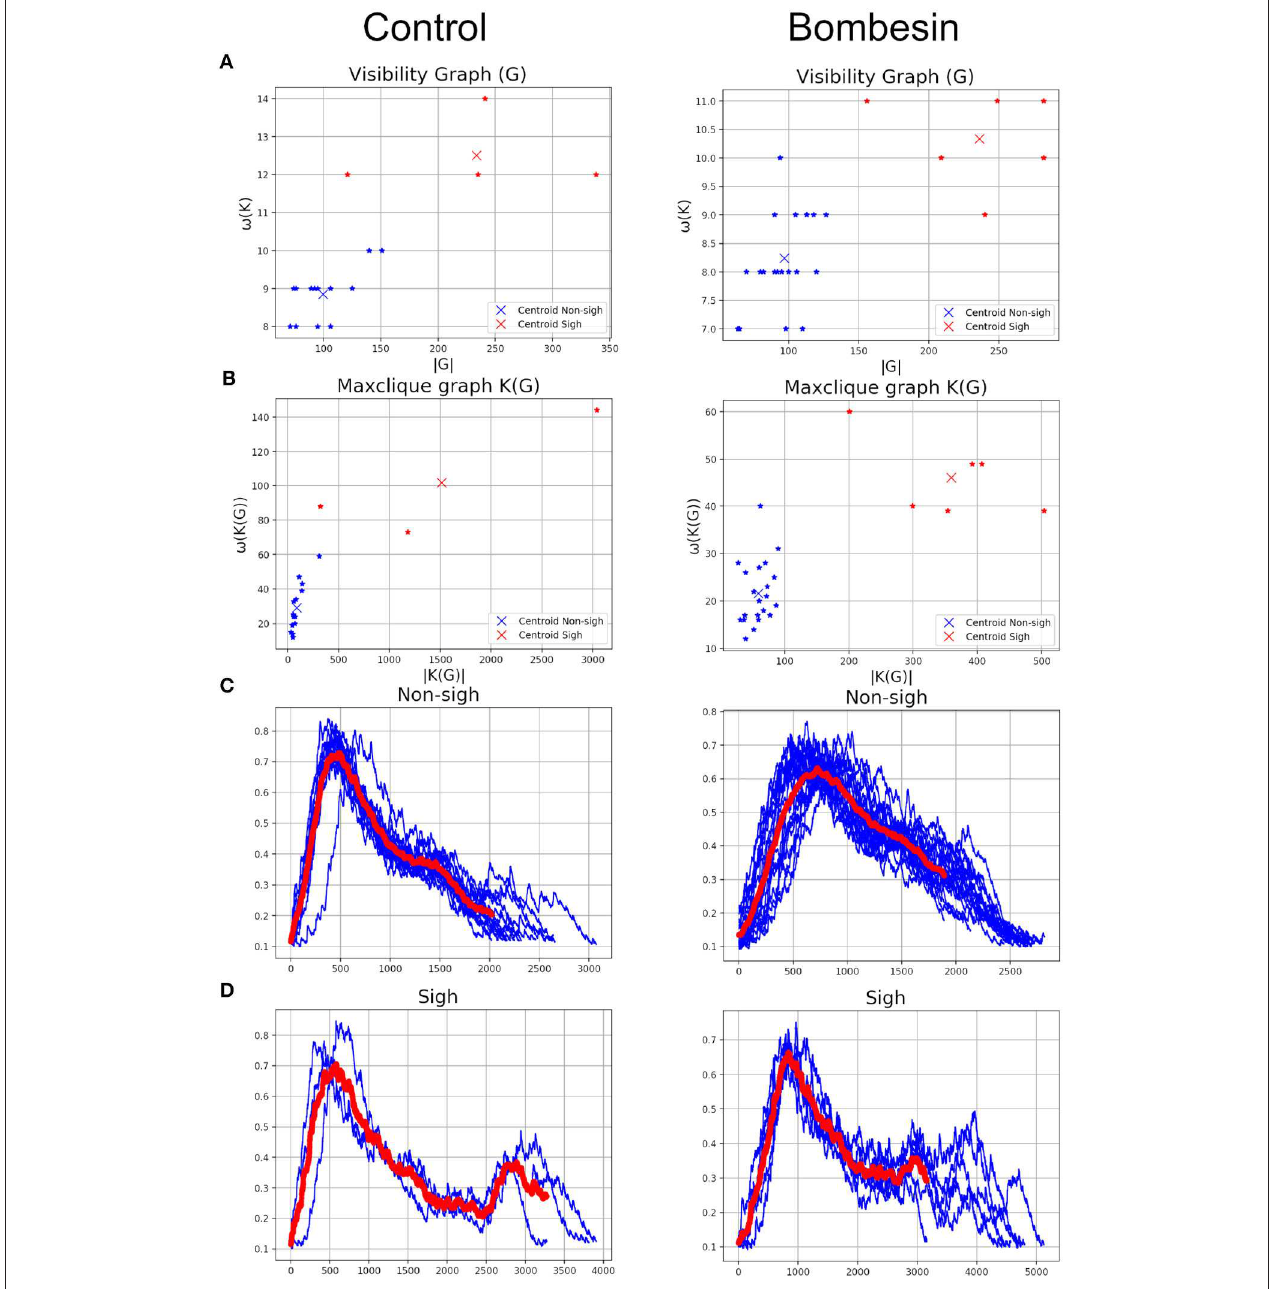
FIGURE 7 | Classification according with clique’s parameters. Control on first column and bombesin recording on second column. (A) Visibility graph and (B) Maxclique graph K-means cluster analysis, (C) non-sighs, and (D) sighs inspiratory bursts. In red are shown the means of all inspiratory bursts classified with Maxclique